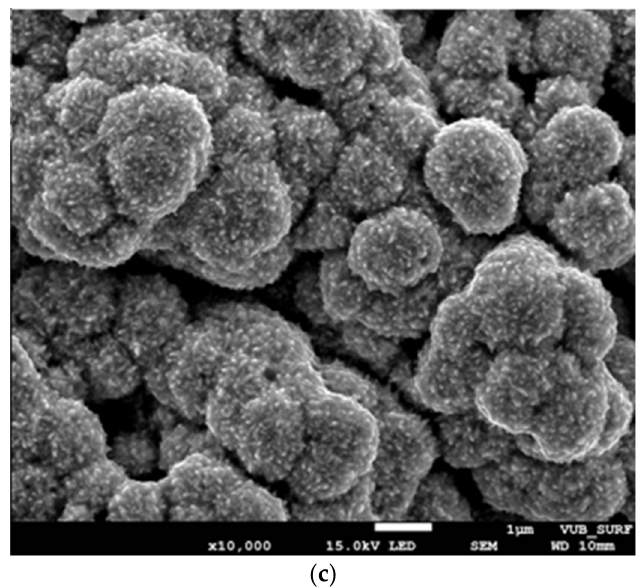
Figure 10. SEM images of electroless deposition of Pt layer on the track obtained by ns-laser ablation of PDMS (wavelength of 266 nm, fluence 35.37 J · cm − 2 ) in water. High-quality metal coating only on the laser-treated area is obtained. Different magnifications are applied to demonstrate ( a , b ) the absence of debris near beside the laser tracks, and ( c ) the cauliflower-like structure of the Pt layer, consisting fine nanograins.